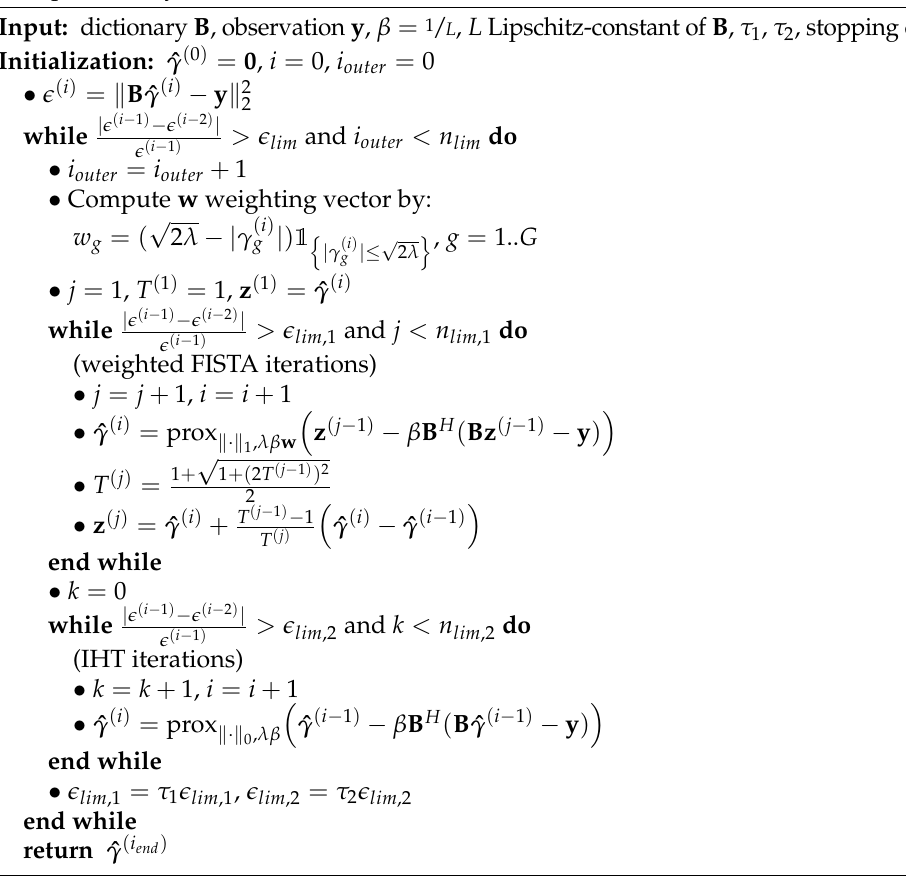
Algorithm 1. Optimization Scheme ALICE-L0 (Alternated Landscapes Iterations for Complementary Enhancement for (cid:96) 0